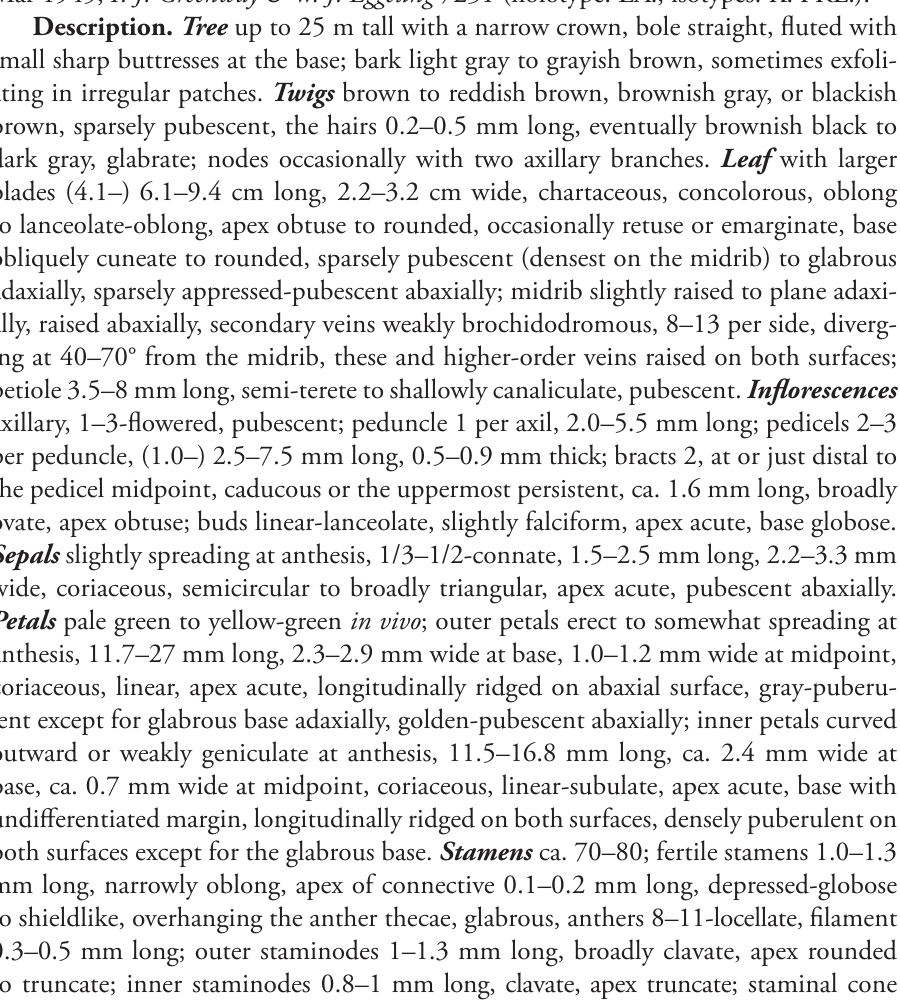
Diagnosis. Species resembling Xylopia holtzii in its branched inflorescences and leaf blades adaxially hairy, but differing in the higher-order veins of the leaf equal in promi- nence to the secondary veins and forming a conspicuous raised reticulum on the adax- ial surface, and the monocarps conspicuously verrucose but not much wrinkled, with stipes 3.5–5 mm thick. Type: UGANDA. Northern Region, Leya and Aiyu river junction, W. Madi,